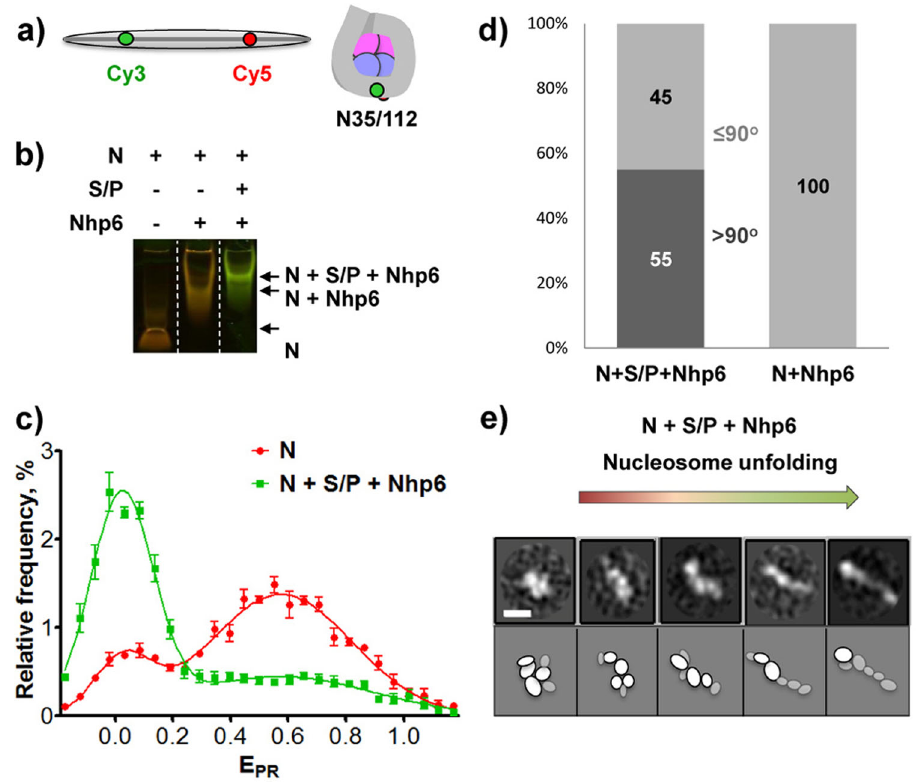
Fig. 3 FACT and Nhp6 unfold nucleosomes into a nearly linear protein – DNA structure. a Schematic of the Widom 603 sequence with Cy3 and Cy5 distant in the free DNA but adjacent in the N35/112 nucleosome (35 and 112 bp from the nucleosome boundary). b Characterization of FACT:Nhp6 complexes with fl uorescently labeled N35/112 nucleosomes (N) by in-gel FRET. Complexes were separated by native PAGE, and the gel was analyzed as described in “ Methods ” . Unfolding of nucleosomal DNA is detected by a decrease in FRET ef fi ciency (transition from red/orange to green). c Typical frequency distributions for nucleosomes N35/112 by the proximity ratios (E PR ) in the absence (red curve) or in the presence of Nhp6 and FACT (green curve). E PR pro fi les were calculated from the FRET ef fi ciencies of individual nucleosomes in solution (average of three independent repeats, mean ± SEM). The maxima of E PR peaks (mean ± SEM) were: N — 0.03 ± 0.00, 0.59 ± 0.03; (N + SP + Nhp6) — 0.02 ± 0.02, 0.55 ± 0.11. d Fractions of closed (<90°) and open (>90°) complexes in FACT:Nhp6:nucleosome and Nhp6:nucleosome complexes. e Representative 2D class averages of FACT:Nhp6:nucleosome complexes with different distances between edges of the complex are arranged to show the proposed sequence of events during nucleosome unfolding by FACT:Nhp6. Scale bar: 10 nm. Bottom: a schematic interpretation of the densities observed by EM to potential domains; less ordered densities are shown in gray. Note that the most compact complex shown on the left is similar to the FACT-subnucleosome complex described previously 21